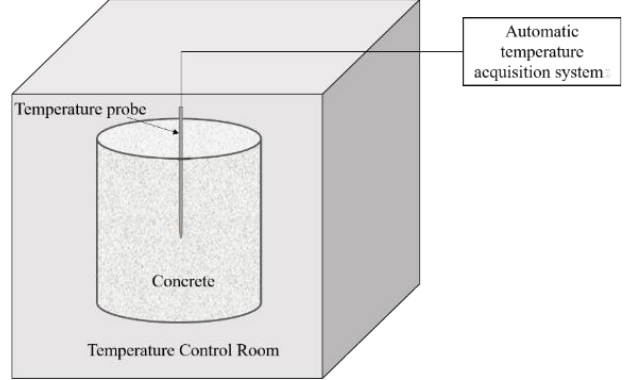
Figure 3. Schematic diagram of adiabatic temperature rise of concrete testing device. Table 3. Proportions of concrete mix (kg/m 3 ).